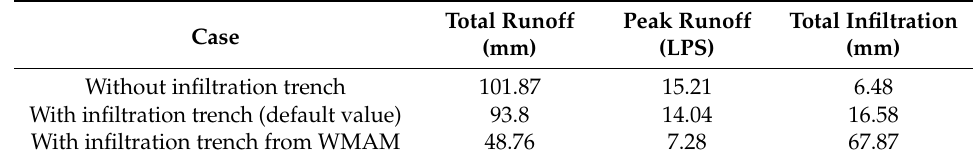
Table 1. Comparison of total runoff, peak runoff and total infiltration for three